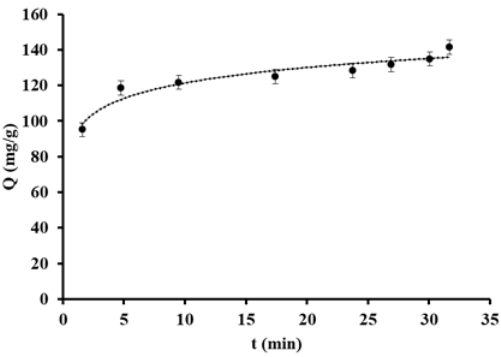
Figure 4. Effect of contact time on the lead ion sorption by the porous polymer composite of 1/6-70- 30.